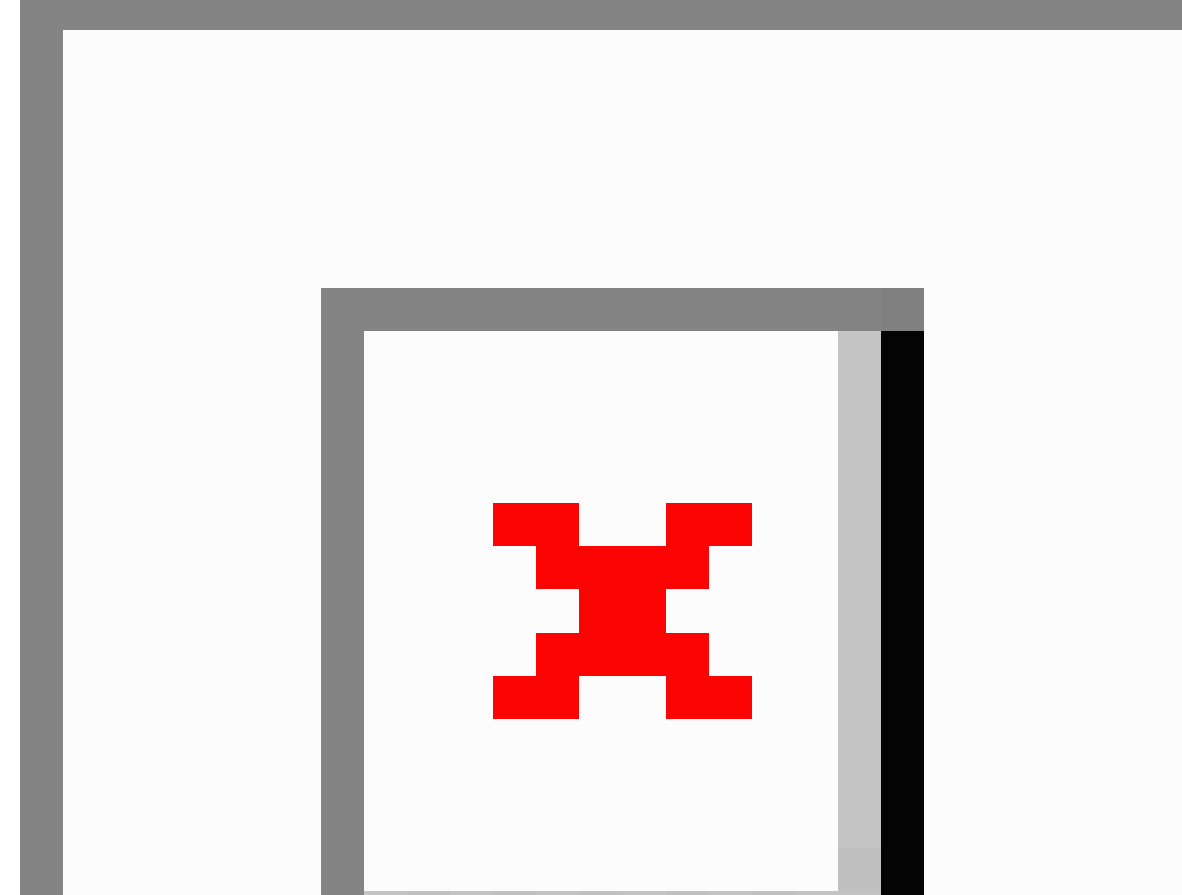
Figure 2. Screenshot of the patient score on one of the questionnaires (Fatigue Severity Scale) as presented to the nurse. The red line indicates the cut-off